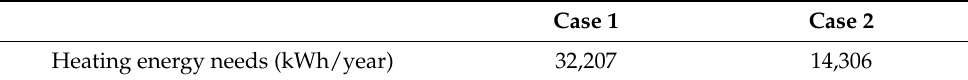
Table 3. Heating and cooling energy demand for the building included in the study in each of the described locations.